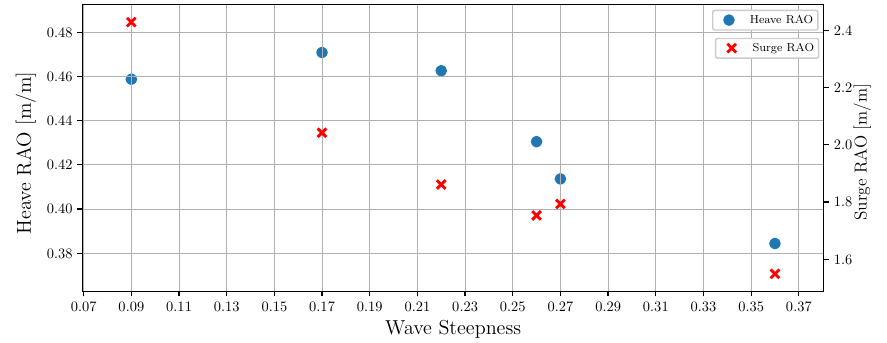
Figure 15. For all the examined sea states, the heave and surge RAOs are shown as a function of the wave